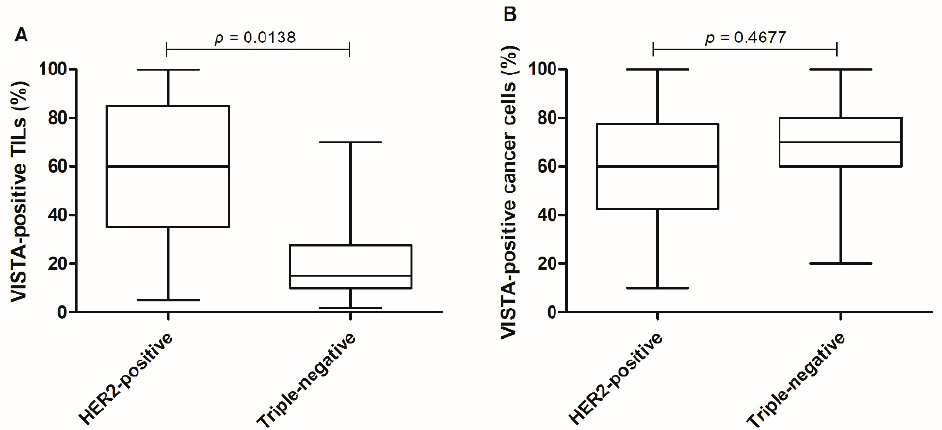
Figure 7. HER2-positive tumors presented higher tissue VISTA expression. ( A ) Categorizing tumor samples by the most aggressive subtypes, HER2-positive and triple-negative tumors, presented differences in the expression of VISTA-positive TILs (* p = 0.0138), ( B ) with no differences reported in VISTA-positive cancer cells ( p =